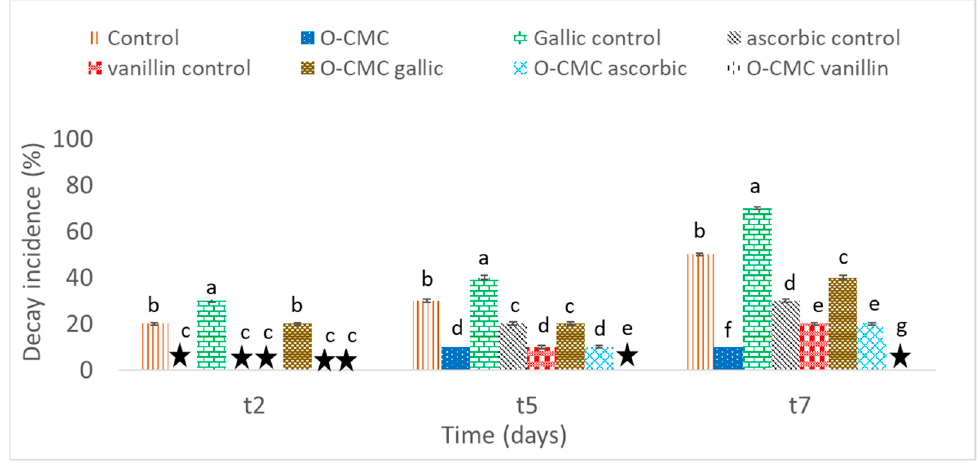
Figure 5. Decay incidence (%) on the strawberries after 2, 5, and 7 days of storage (t2, t5, and t7, respectively). The sign designates cases when no decay was detected. Values followed by a dif- ferent letter within the same sampling time are significantly different according to Tukey HSD test at p ≤ 0.05.